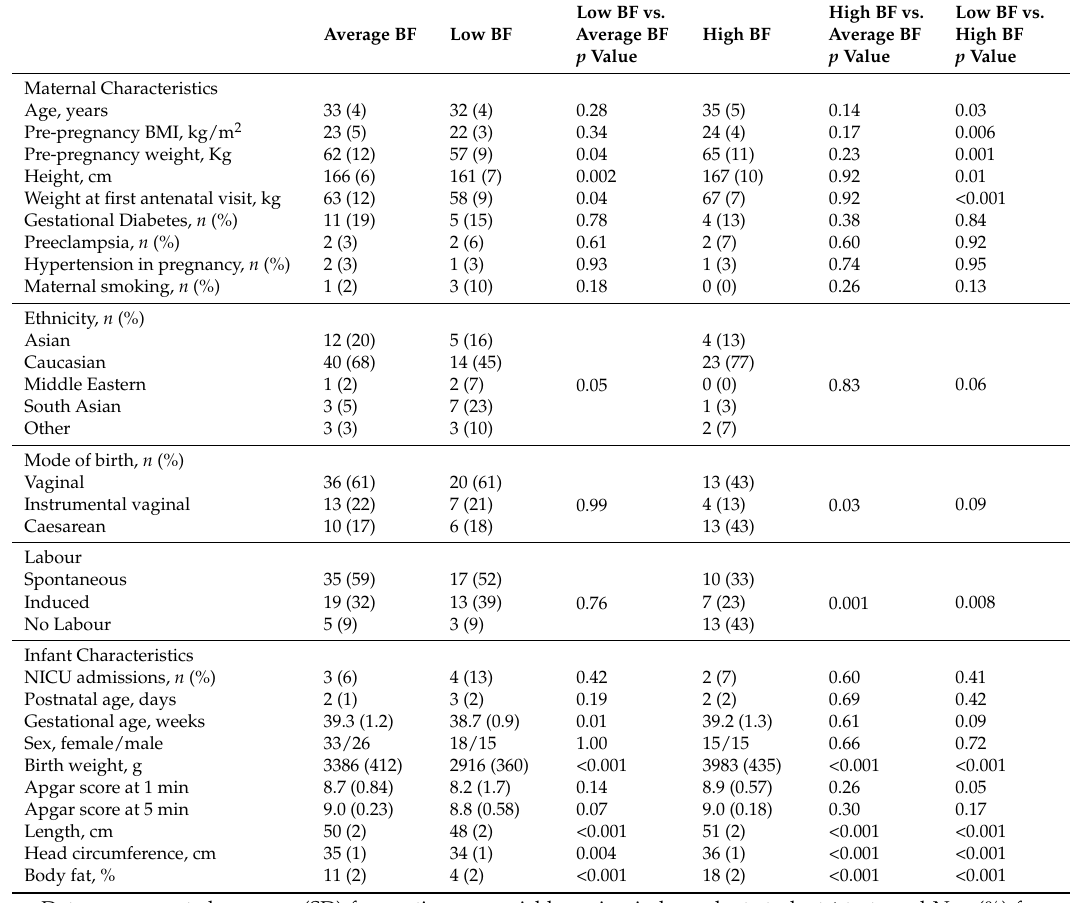
Table 1. Maternal and infant